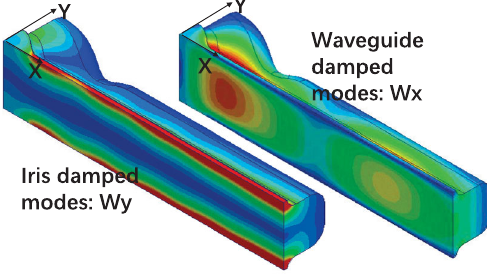
FIG. 5. Suppression of the HOMs in two polarizations.